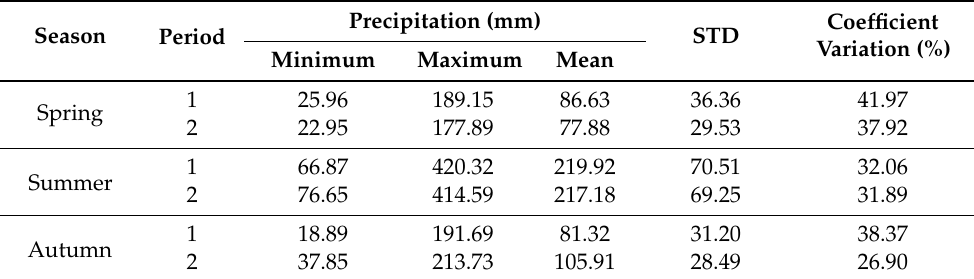
Table 1. Statistical characteristics of seasonal precipitation on the Loess Plateau.